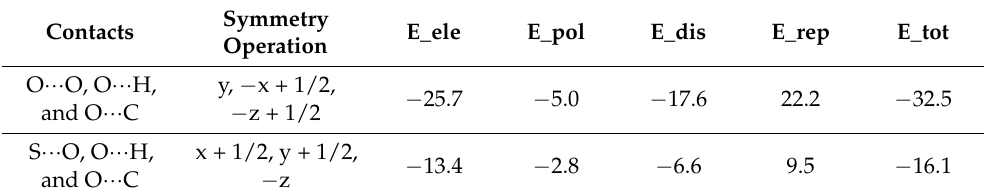
Table 3. Selected interaction energies (kJ/mol) (with E_tot > − 50.0 kJ/mol) for 4 .